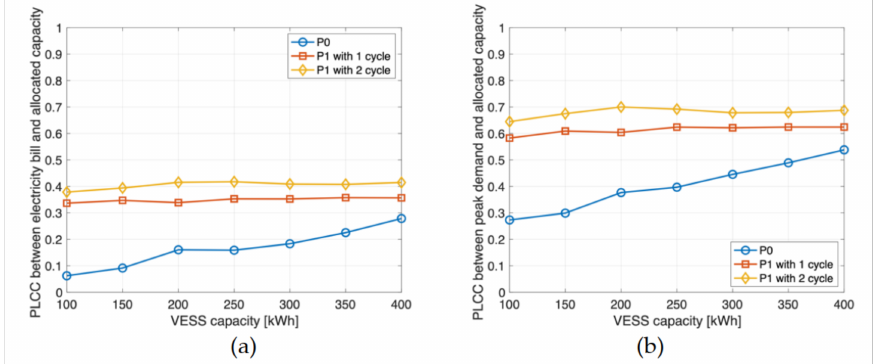
Figure 7. Pearson’s linear correlation coefficient (PLCC) between the characteristics of the participants and the allocated VESS capacity with varying implemented VESS capacity: ( a ) PLCC between the original electricity bill and the allocated VESS capacity; ( b ) PLCC between the peak demand and the allocated VESS